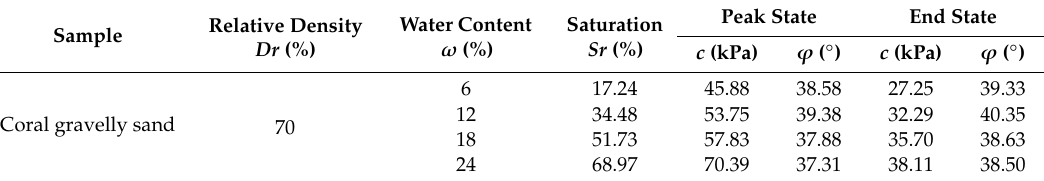
Table 4. The shear strength parameters of coral gravelly sand under di ff erent stress